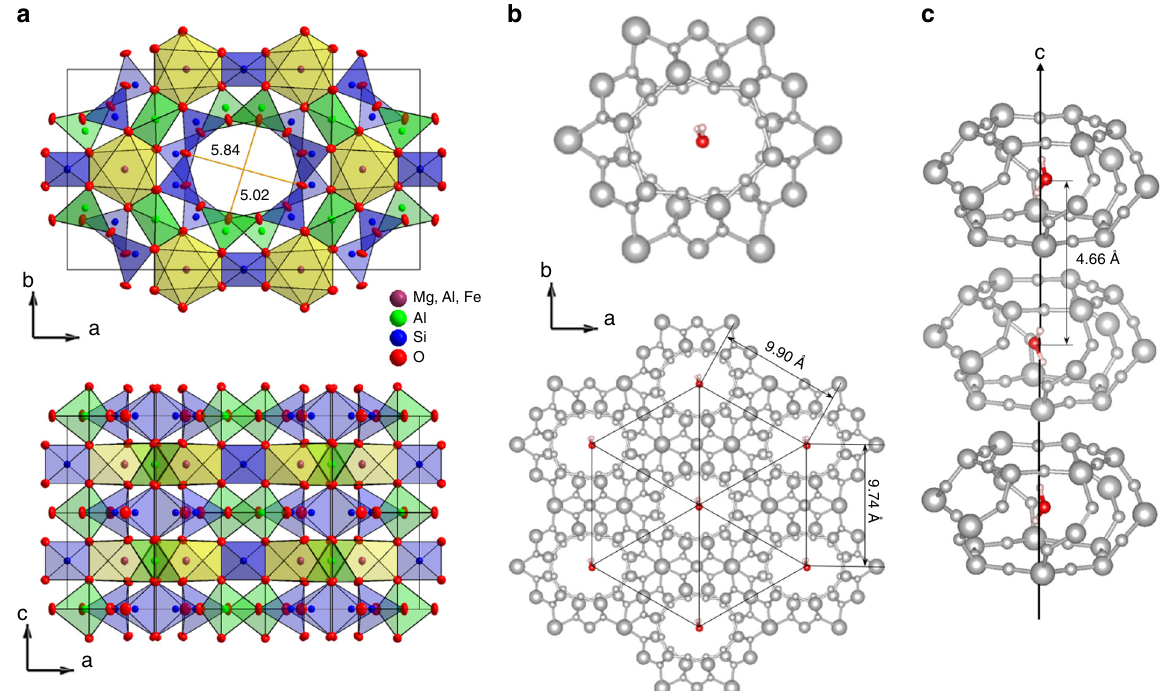
Fig. 1 Cordierite crystal structure with water molecules within ionic nanopores. a Unit cell of cordierite crystal from X-ray analysis with thermal ellipsoids at 85 K. b The water molecules within cordierite nanopores form two-dimensional triangular lattice within the ab -plane. c One-dimensional chain of con fi ned water molecules along the c